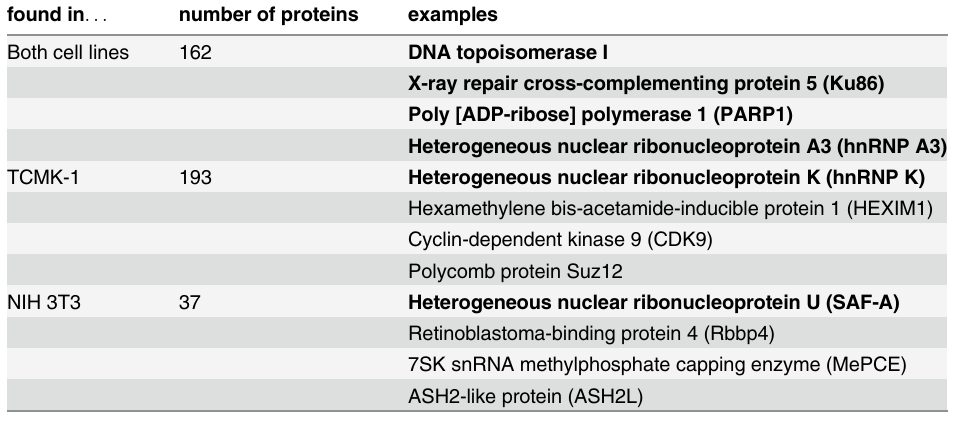
Table 1. Proteins associated with the right oriLyt as identified by DNA-affinity purification and mass spectrometry analysis a . found in ...